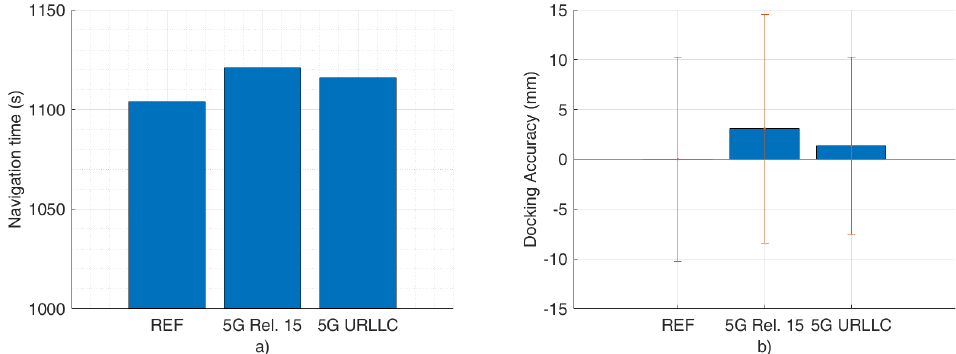
Figure 12. Results from the MEC-planner performance for the cabled reference case and the dif- ferent 5G network configurations explored in the emulation tests: ( a ) navigation performance, and ( b ) docking